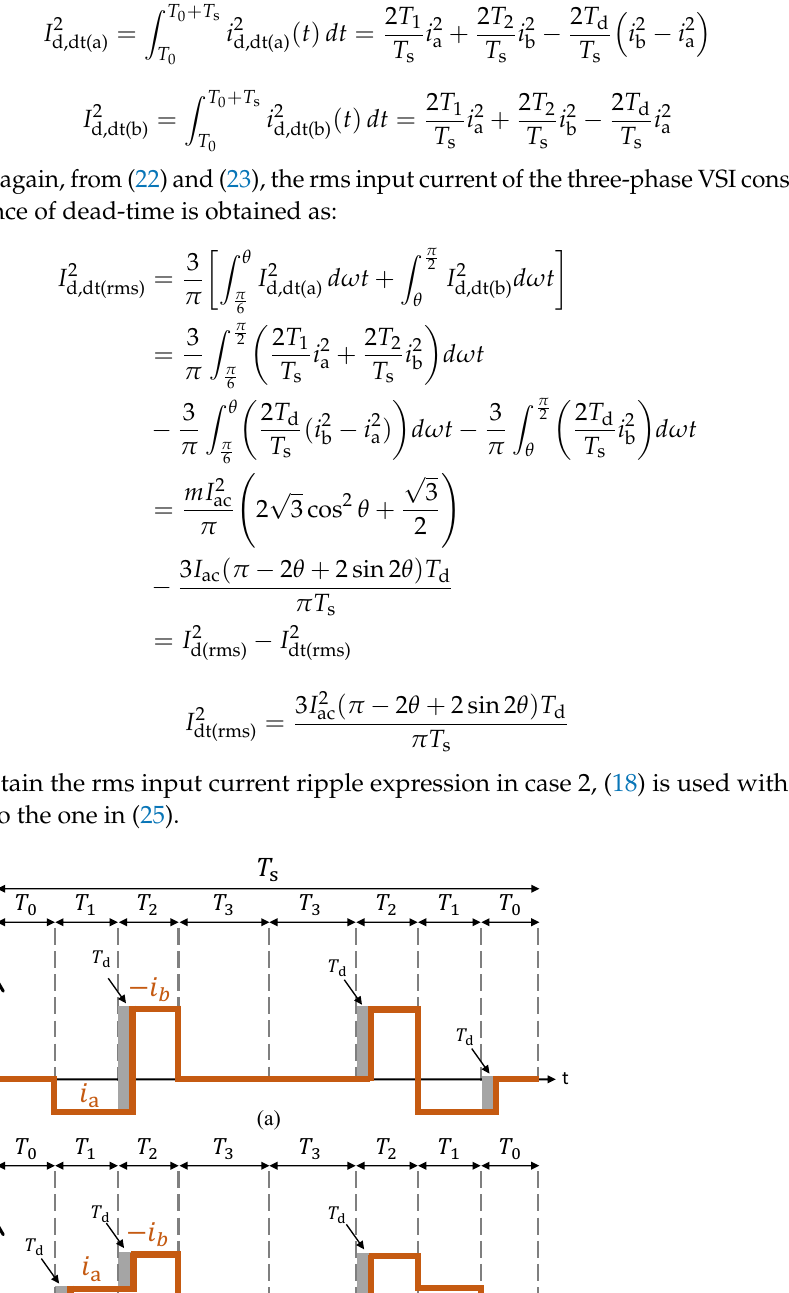
Figure 4. Input current waveform of a three-phase VSI (case 2: θ > 30 ◦ ) for intervals: ( a ) π ( b ) θ ≤ ω t ≤ π 2